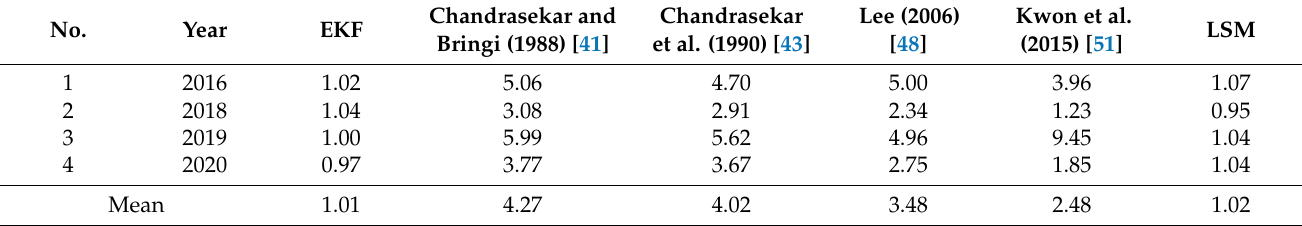
Table 4. G/R ratios of the radar rain rate depending on different radar rain rate estimators.